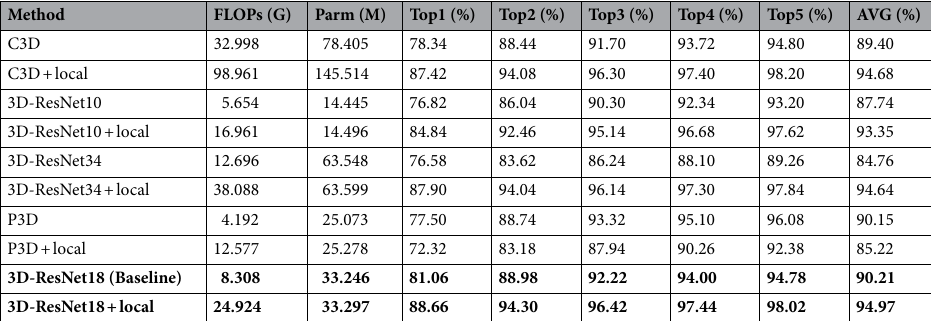
Table 4. Comparison of experimental results of different 3D-CNN networks. Experimental results of our method are in bold.